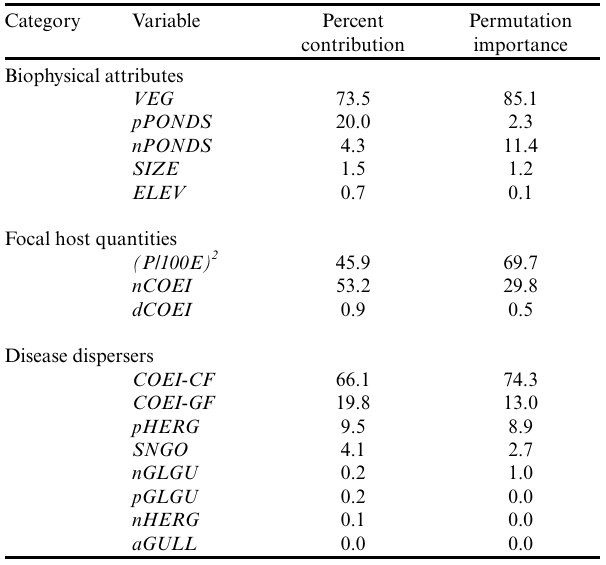
Table 4 . Best supported variables in category-specific analyses of Avian Cholera outbreak probability predictors at Common Eider ( Somateria mollissima ) breeding